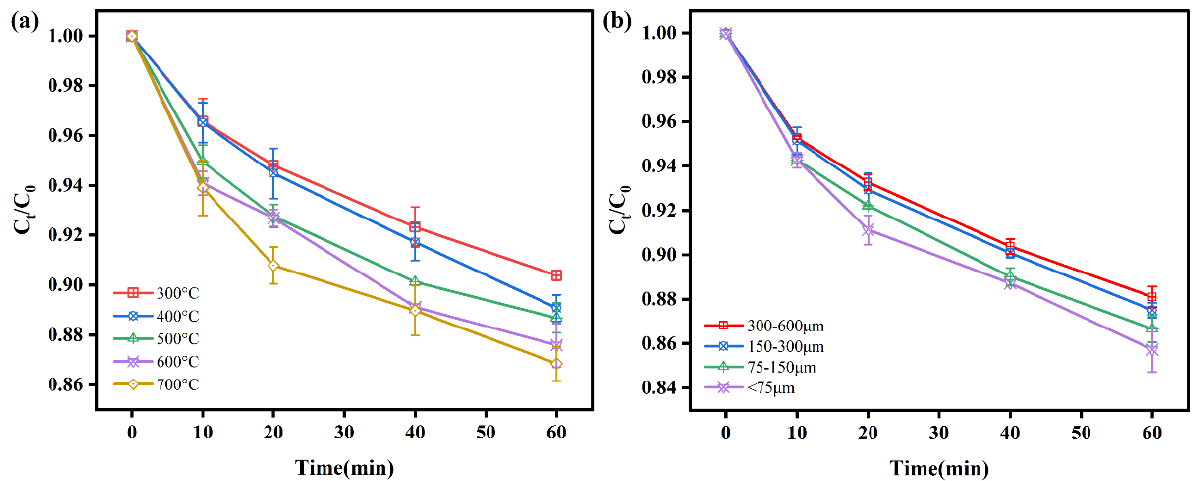
Figure 4. Cr(VI) removal by RBC prepared at different pyrolysis temperatures ( a ); RBC with different particle sizes ( b ); experimental conditions: initial Cr(VI) concentration 20 mg/L, RBC dosage 0.5 g/L, T = 25 °C, pH = 5.